Question: What visual encoding does this figure use to show its data?
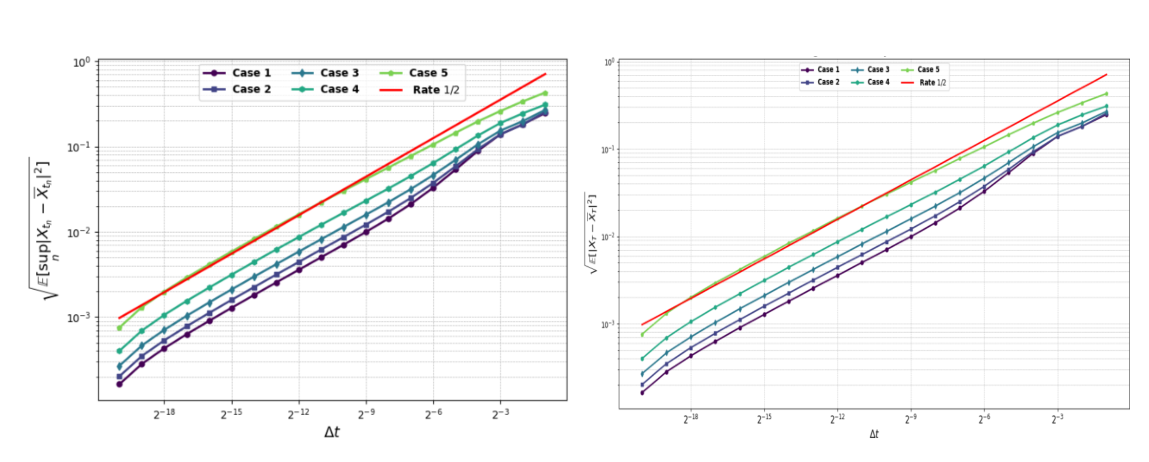
Answer: line